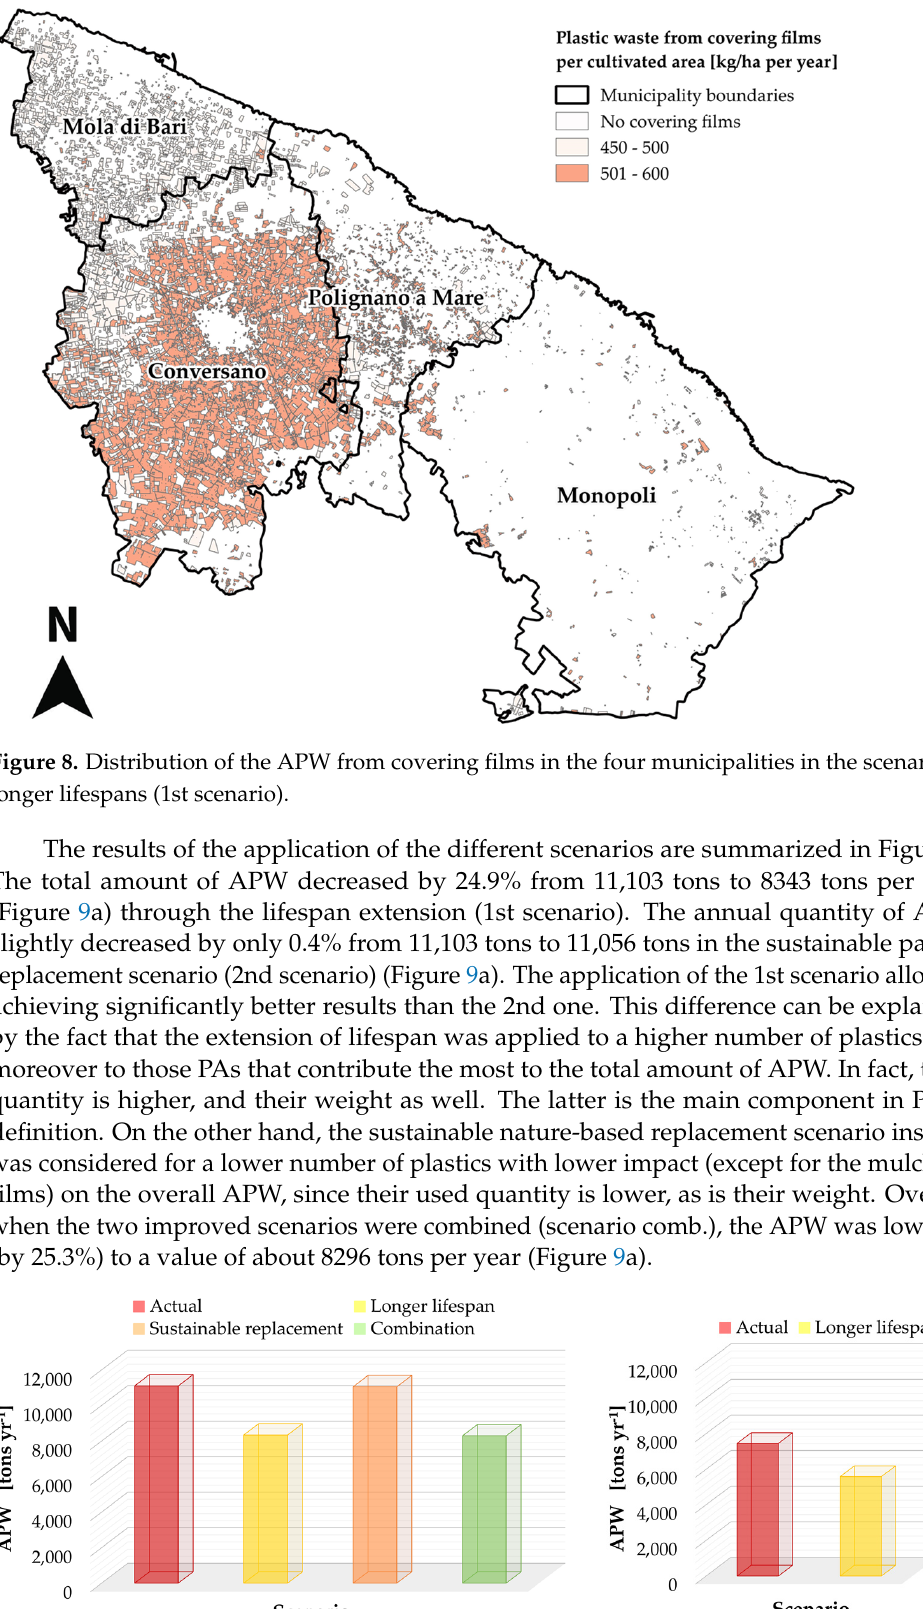
Figure 9. Yearly amount of APW in the different scenarios from overall plastics ( a ) and from covering films only ( b